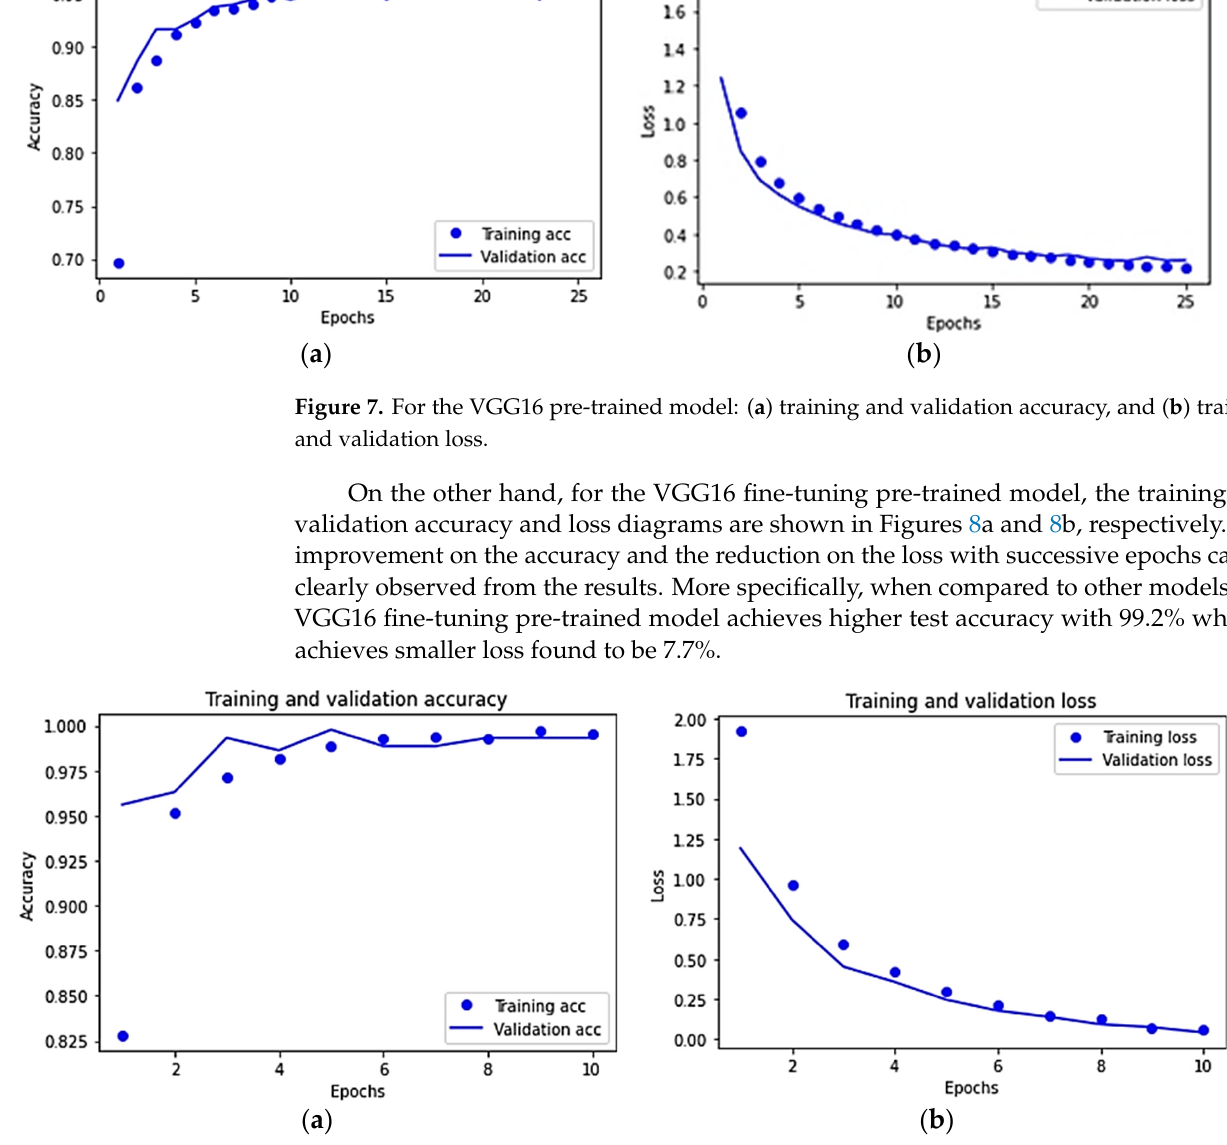
Figure 6. For the proposed model: ( a ) training and validation accuracy, and ( b ) training and valida- tion loss.